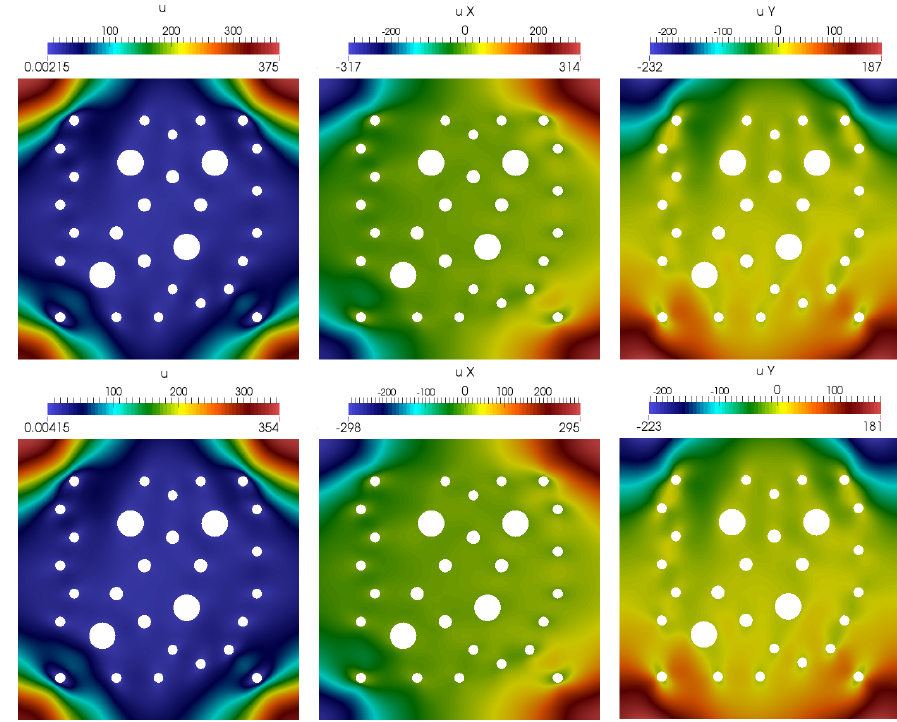
Figure 7. The distribution of the velocity. Magnitude of velocity, x and y components of velocity, u , u x u y (from left to right). ( Top ): Reference (fine grid) solution, DOF f = 433,384. ( Bottom ): Multiscale solution, DOF c = 4100 (0.9% from DOF f